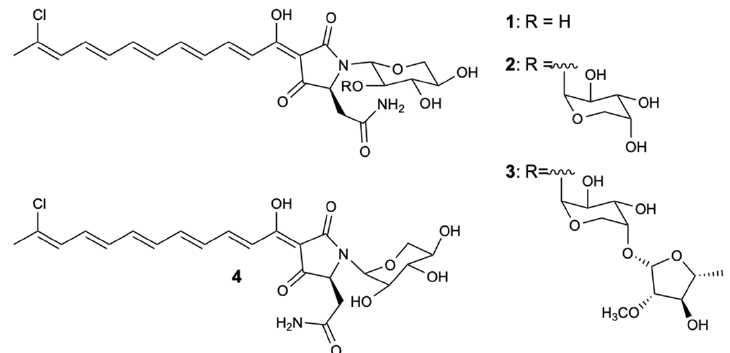
Figure 3. Structure of aurantosides G–J ( 1 – 4 ).